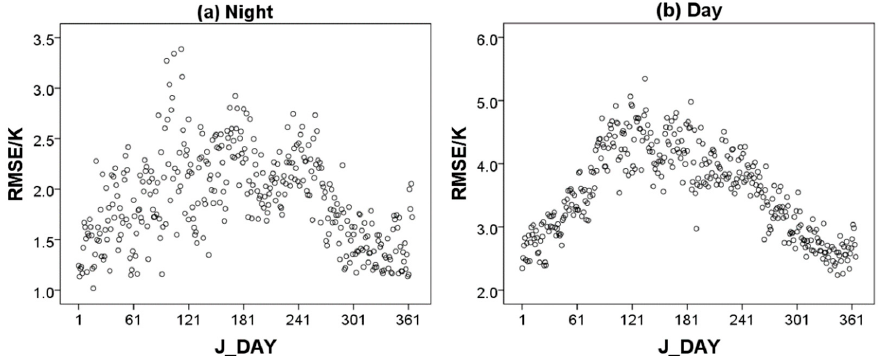
Figure 13. RMSE between the predicted LST and MODIS LST at night and daytime. ( a ) night. ( b ) day.